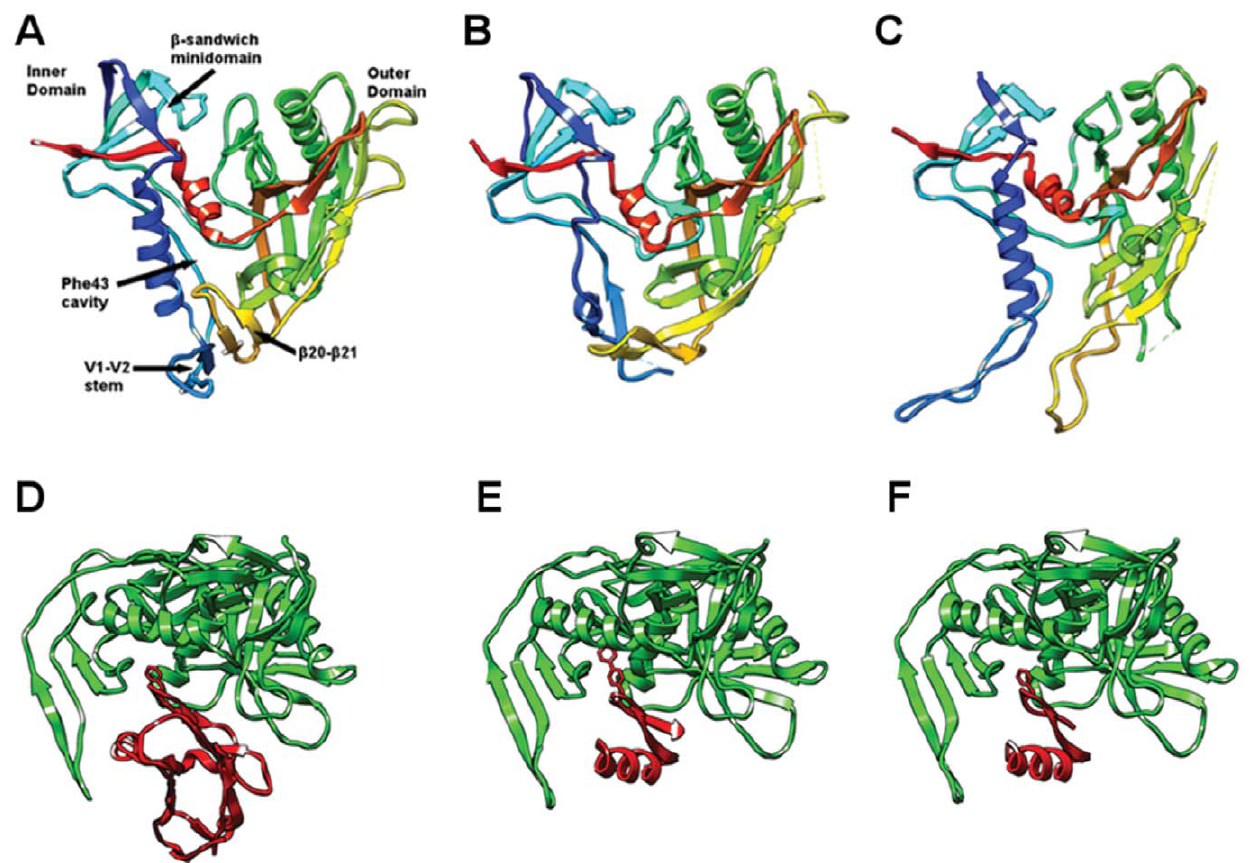
Figure 1. Structure of gp120 in different ligation states. ( A–C ) Comparisons of gp120 structures in ( A ) the CD4-bound state (PDB ID: 1G9N) [10], ( B ) the b12 antibody-bound state (PDB ID: 2NY7) [17], and ( C ) the F105 antibody-bound state (PDB ID: 3HI1) [20]. Structures are rendered as ribbon diagrams colored spectrally along the sequence from blue at the N-termini to red at the C-termini. The view is into the face occupied by CD4 interactions. ( D–E ) Comparisons of complexes between gp120 and various protein ligands: gp120 with ( D ) CD4 (PDB ID: 1G9N) [10]. ( E ) CD4M33 (PDB ID:1YYL) [16] and ( F ) F23 (PDB ID: 1YYM) [16]. Structures are rendered as ribbon diagrams with gp120 molecules in green and CD4 or its mimetics in red. The view has gp120 molecules rotated by , 90 u about the horizontal axis relative to the upper set ( A–C ).